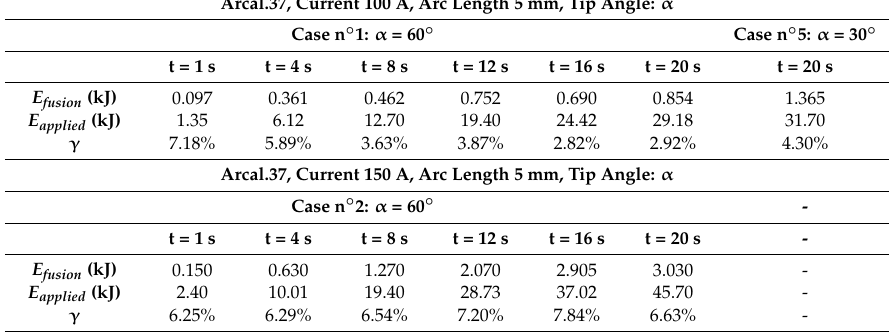
Table 3. The table indexes the applied energy ( E applied ) estimated with measurements of voltage and current intensity during the interaction and the energy ( E fusion ) involved to fuse the amount of metal related to the weld pool